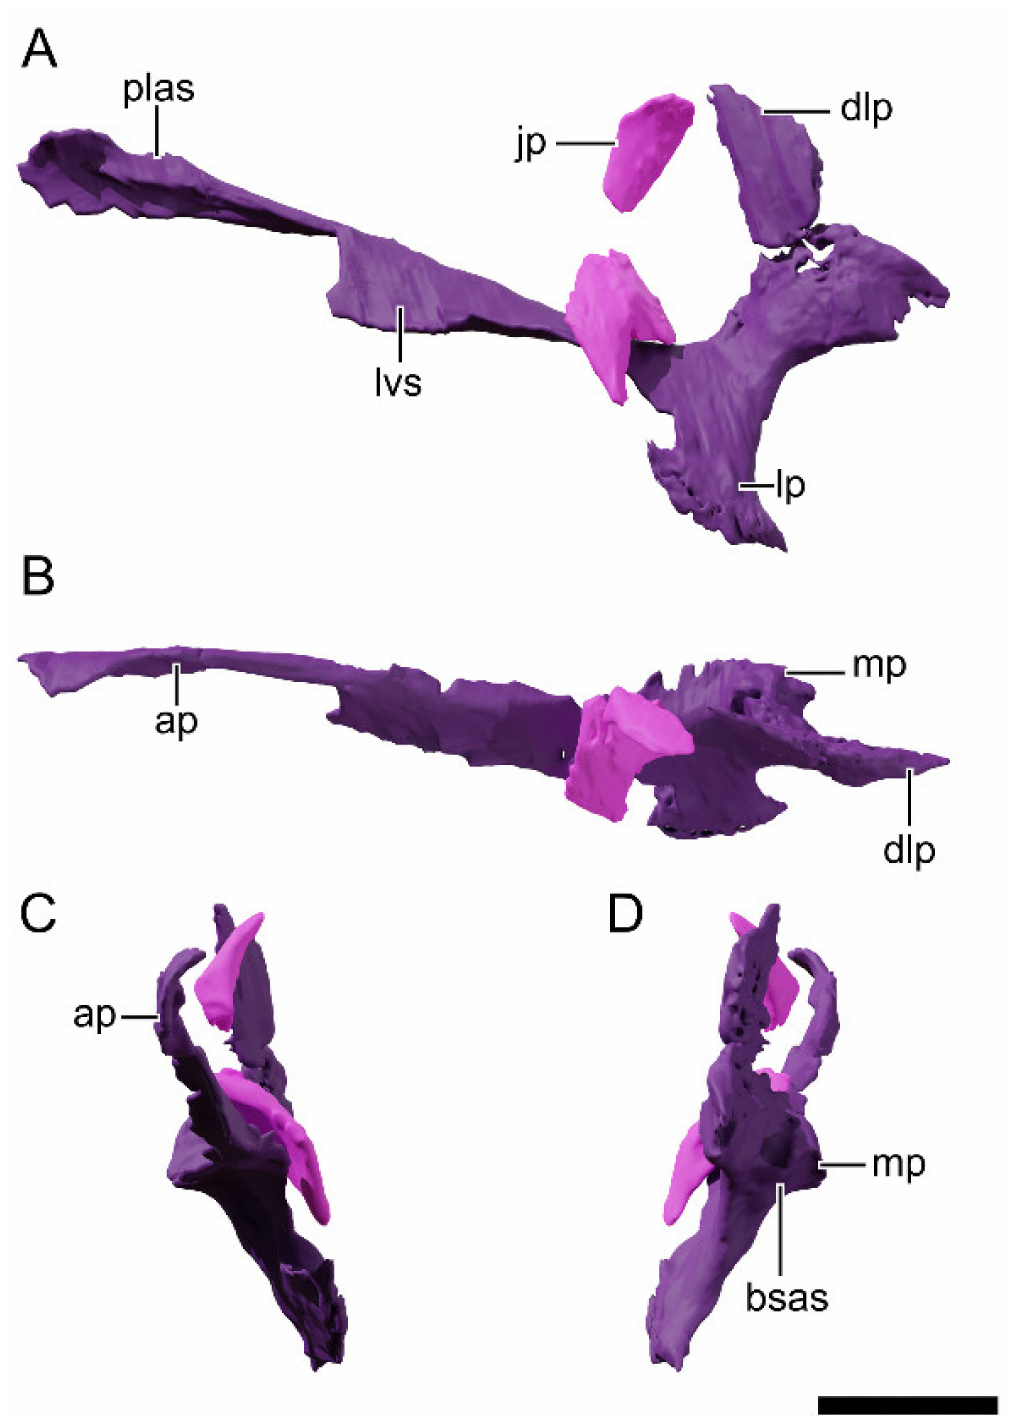
Figure 27. Digital reconstruction of the left pterygoid and ectopterygoid of NHMD 164741. ( A ) Lateral view. ( B ) Dorsal view. ( C ) Anterior view. ( D ) Posterior view. Abbreviations: ap, anterior process; bass, articular surface for the basisphenoid; dlp, dorsolateral process; ecf, ectopterygoid fossa; jp, jugal process; lp, lateral process; lvs, lateroventral sheet of bone; mp, medial process; plas, articular surface for the palatine. Scale bar = 20